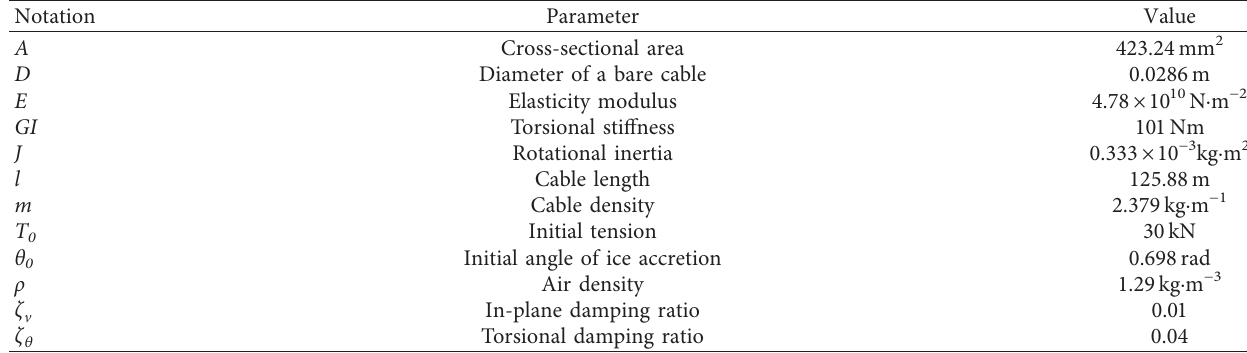
Figure 1: Theoretical model of the iced transmission line. (a) Configuration. (b) Cross-section. Table 1: Parameters of iced transmission